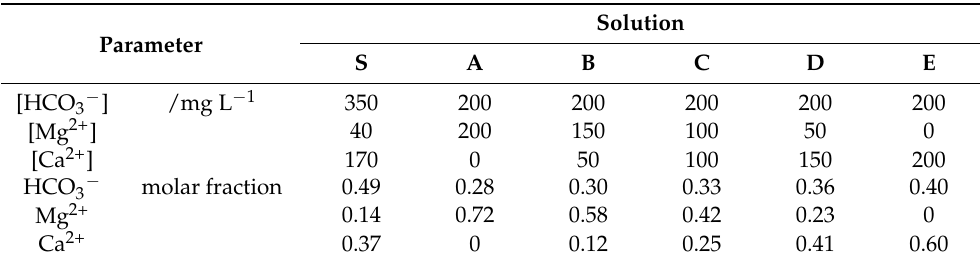
Table 1. Composition of the aqueous solutions utilized in the experiments, with molar fractions for HCO 3 − + Ca 2+ + Mg 2+ =